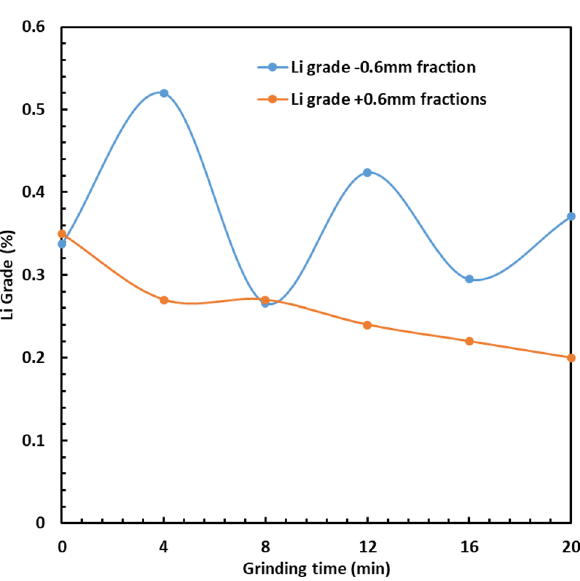
Figure 4. Effect of closed-circuit grinding time and screening on lithium grade in the two size fractions: − 0.6 mm and + 0.6